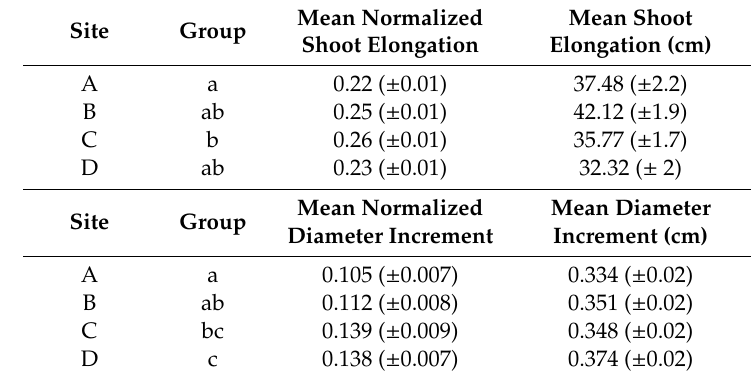
Table 5. Results of the post hoc tests used to assess the di ff erences in tree growth during the season. Parameters being tested were the mean normalized values of apical shoot elongation and diameter increment. Mean values, both normalized and absolute (cm), are also shown for each site. “Group” letters identify statistically di ff erent groups, where “a” is the group with the lower value. Values in brackets represent the standard error (S.E.).